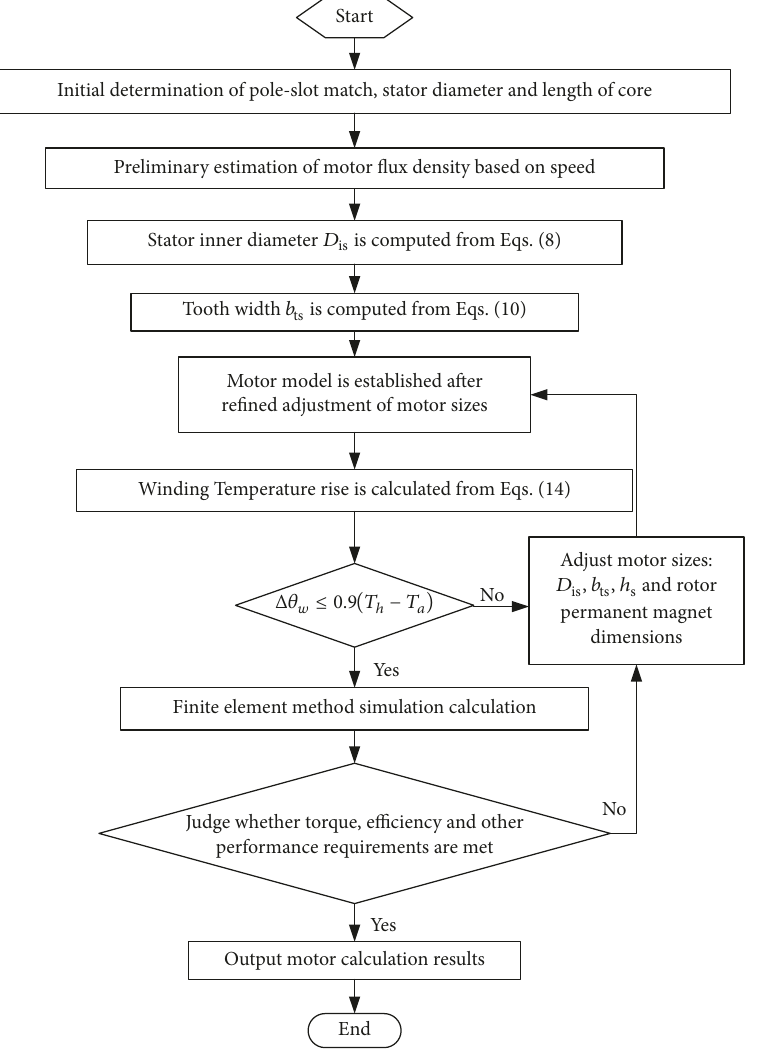
Figure 2: Electromagnetic-thermal integration design